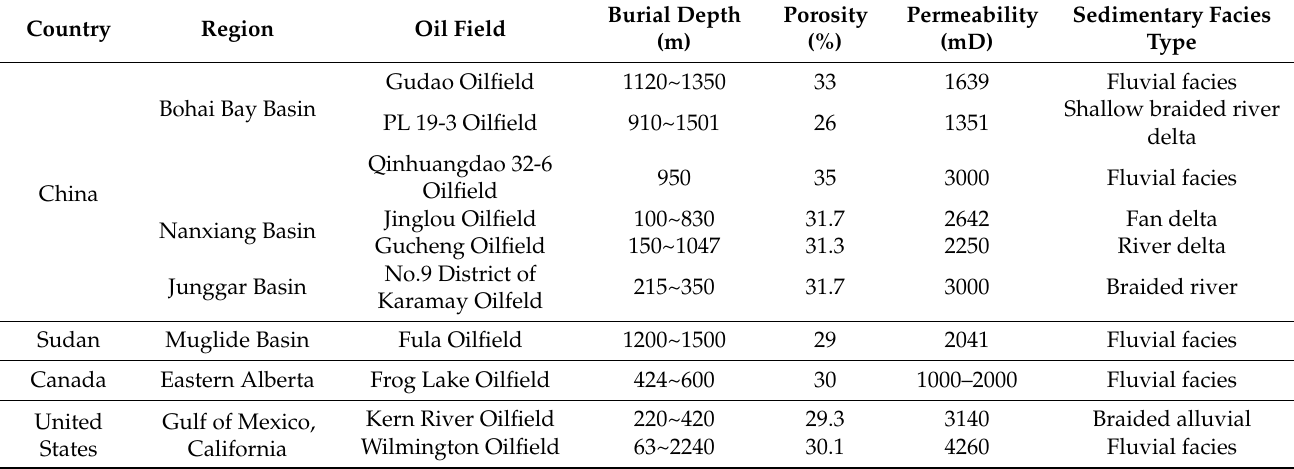
Table 8. Characteristics of some unconsolidated sandstone